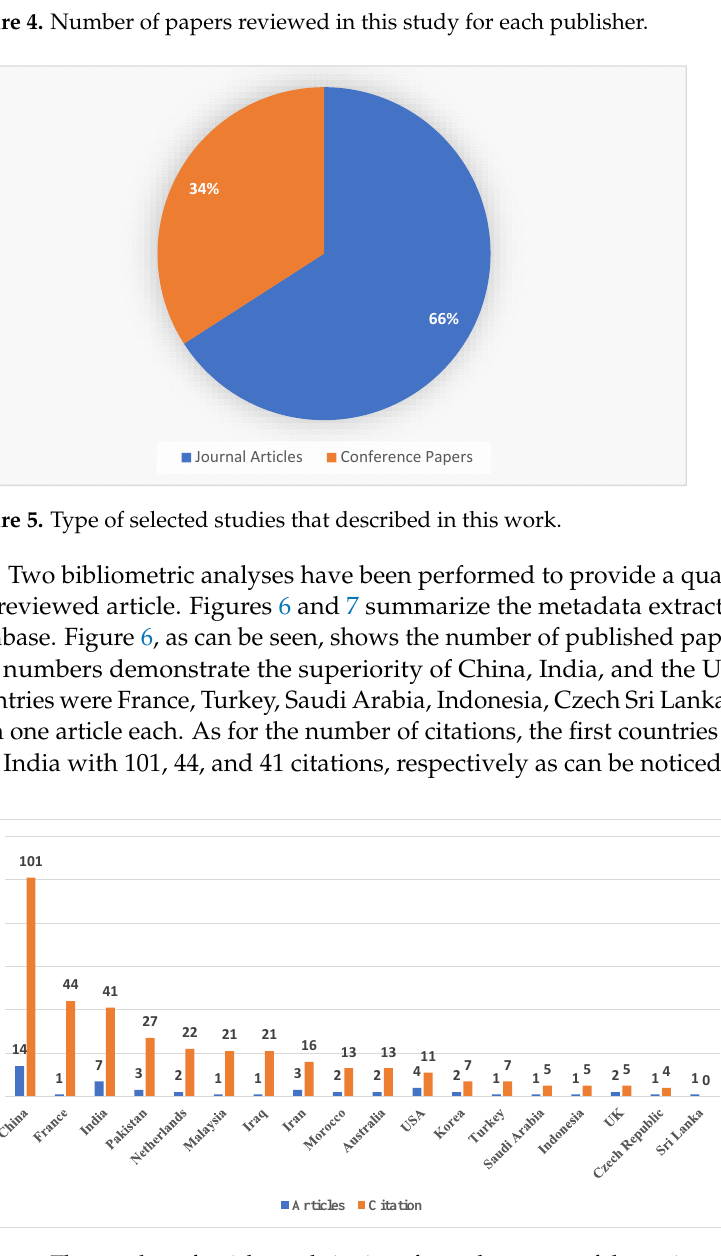
Figure 6. The number of articles and citations for each country of the reviewed